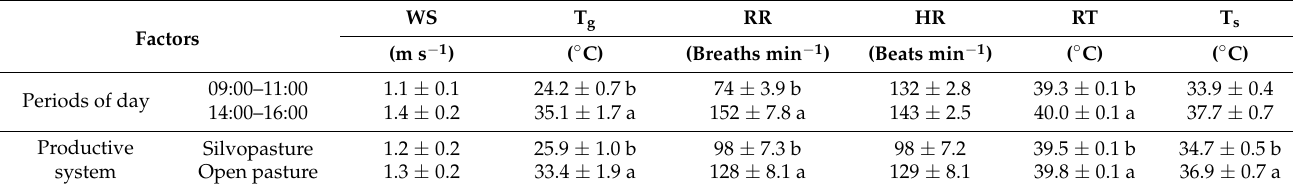
Table 3. Average values (mean ± SEM) of wind speed (WS), ground surface temperature (Tg), respiratory rate (RR), heart rate (HR), rectal temperature (RT), and hair coat surface temperature (Ts) between the productive systems and throughout the periods of the